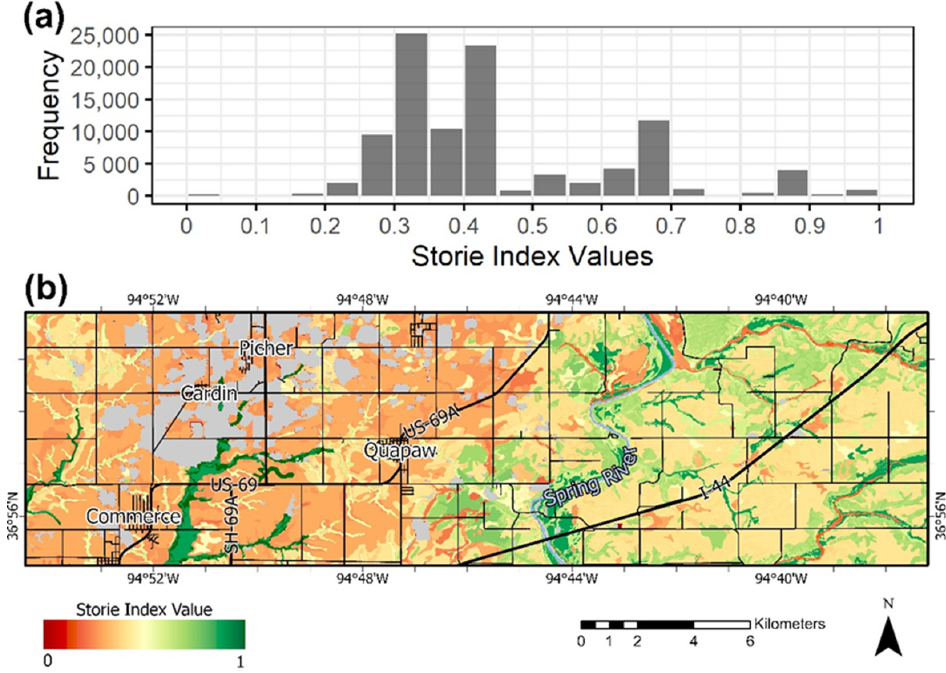
Figure 2. ( a ) Frequency distribution of Storie crop suitability index values for soils within the Quapaw Tribal lands and ( b ) the spatial distribution of Storie index values.